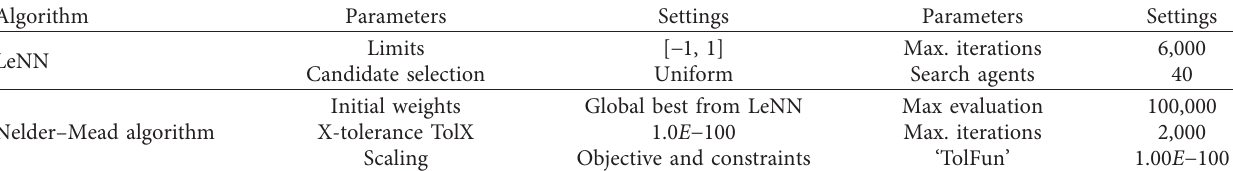
Table 6: Setting of parameters for LeNN and NM algorithm.